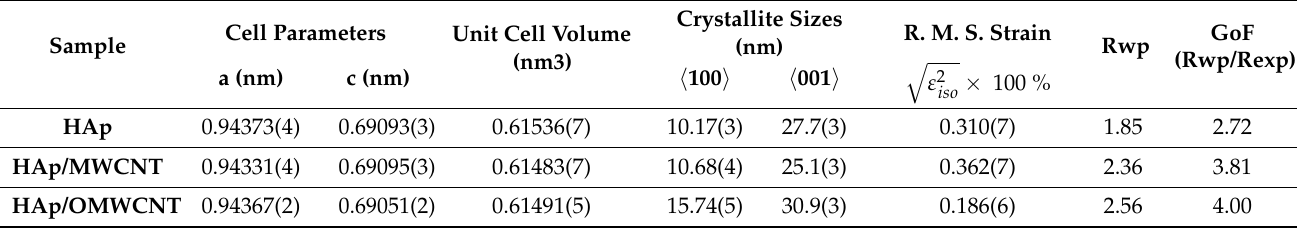
Table 1. Results of the Rietveld analysis of HAp, HAp/MWCNT, and HAp/OMWCNT samples. The numbers in parentheses denote the uncertainty in the last